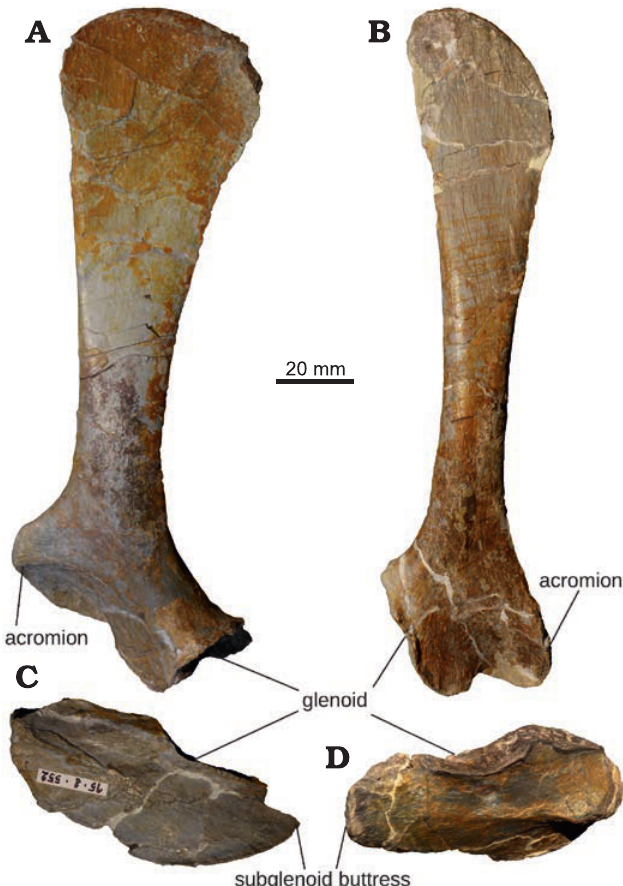
Fig. 7. Pectoral girdle of juvenile Plateosaurus cf. trossingensis Fraas, 1913 skeleton MSF 15.8B. from the Norian of Frick, Switzerland. A . Left scap- ula, MSF 15.8.55. B . Right scapula, MSF 15.8.870. C . Left coracoid, MSF 15.8.552. D . Right coracoid, MSF 15.8.1035. All in lateral (external)